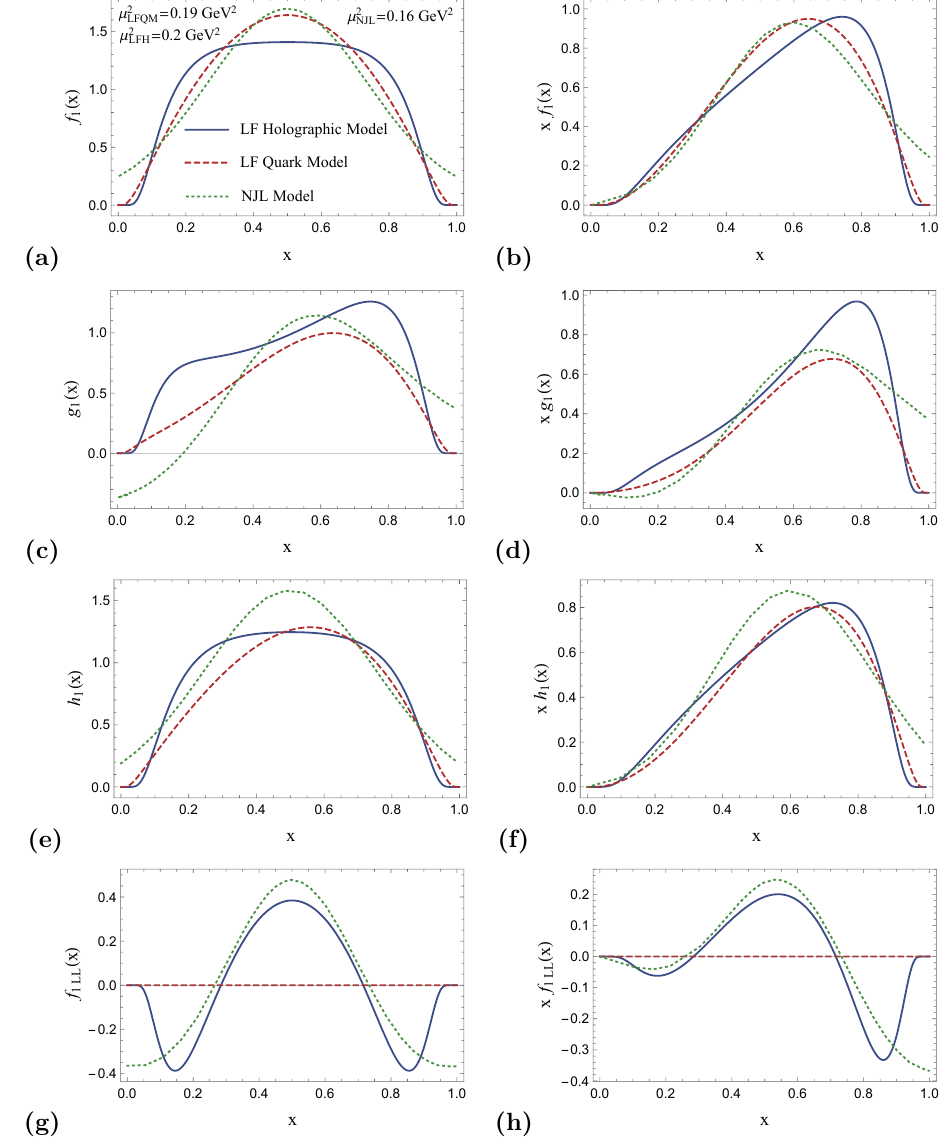
Figure 7 . Left panel: the PDFs: f 1 ( x ) , g 1 L ( x ) , h 1 ( x ) and f 1 LL ( x ) as functions of x . Right panel: the PDFs multiplied by x , i.e., xf 1 ( x ) , xg 1 L ( x ) , xh 1 ( x ) and xf 1 LL ( x ) are plotted with respect to x . The solid-blue and dashed-red curves represent the results evaluated in the LF holographic model and the LF quark model, respectively. Our results are compared with the predictions of the NJL model (dotted-green curves)